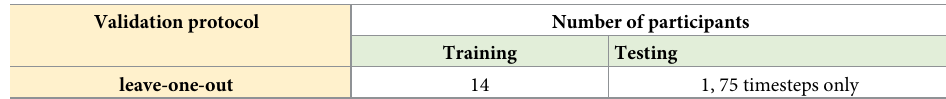
Table 1. Train-test split